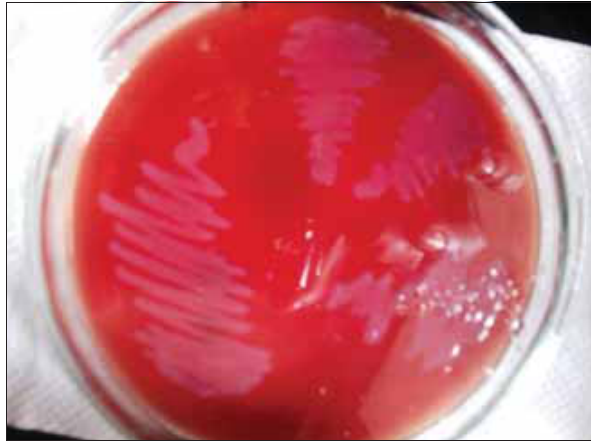
Figure-1: Blood agar plate showing Riemerella anatipestifer